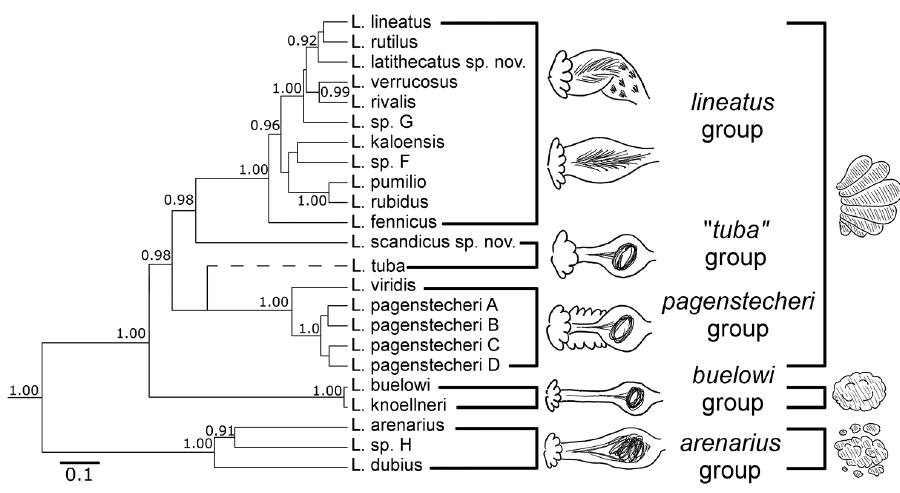
Figure 1. Phylogeny of North European Lumbricillus , modified from Klinth et al. (2017). Species tree based on 12S, 16S, COI, 18S, 28S, ITS and H3 genes, estimated using Bayesian inference under the multispecies coalescent model in * BEAST. Posterior probabilities higher than 0.9 shown as support values. Scale shows expected number of changes per site in COI with all other genes relative to it. Lumbricillus tuba has been added to the tree at the most probable position given the other gene and species trees from Klinth et al. (2017). The tree depicts the five morpho-groups that are used in the present study to discuss the relationships within Lumbricillus . The general morphology of the spermathecae and testes/testis sacs of these groups are also shown.